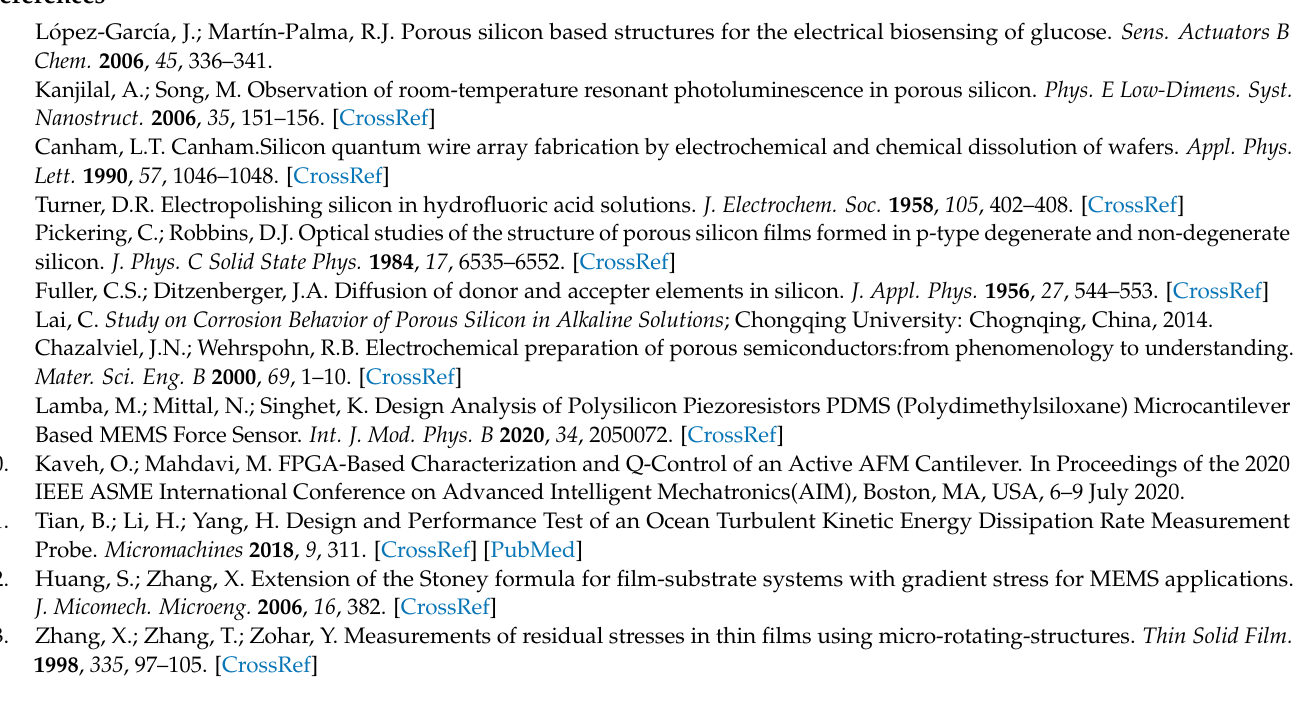
Figure 7. Real photo of multilayer composite cantilever with piezoelectric sensitive film and metal film.